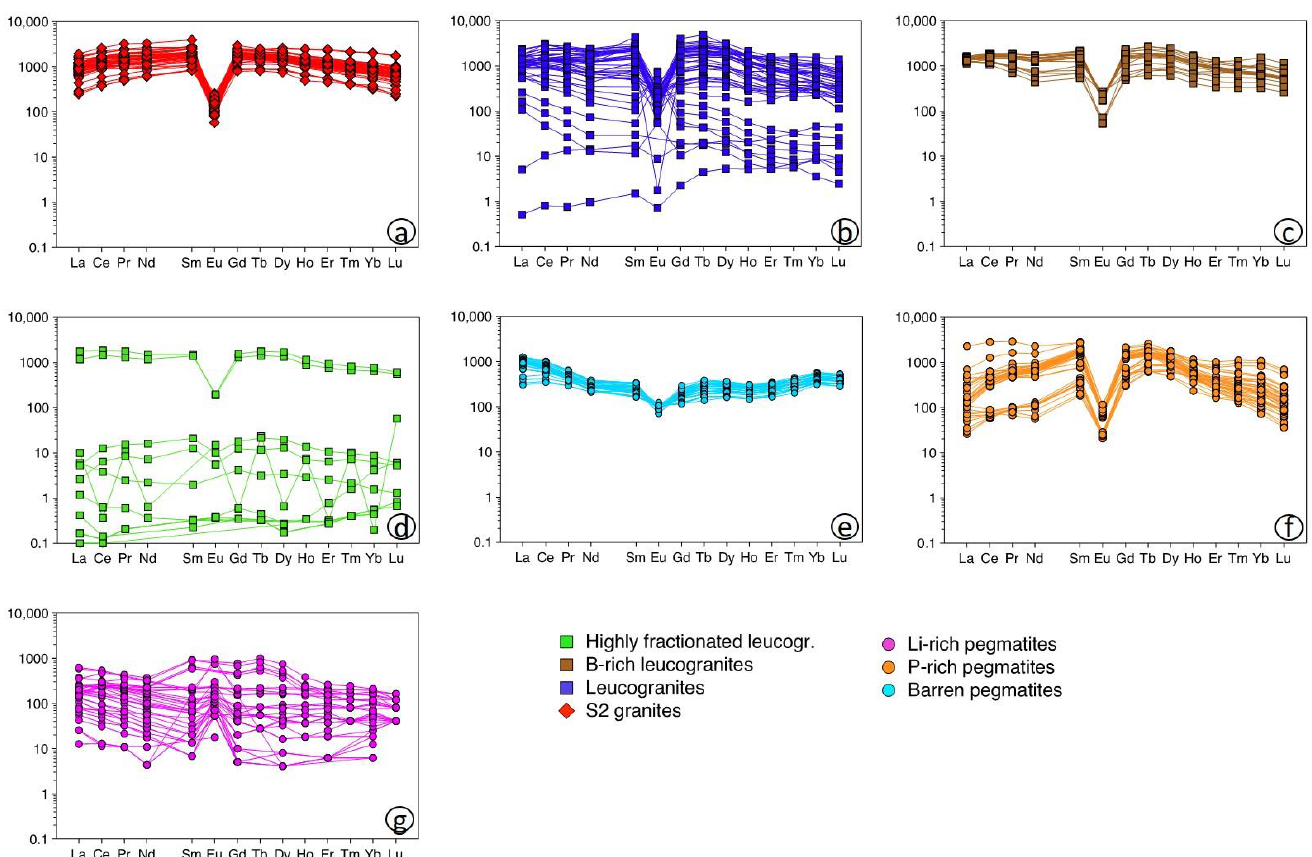
Figure 9. Chondrite-normalized (McDonough and Sun, [106]) apatite REE patterns for: ( a ) S 2 granites, ( b ) leucogranites; ( c ) B-rich leucogranites; ( d ) highly fractionated leucogranites; ( e ) barren pegmatites; ( f ) P-rich pegmatites; and ( g ) Li-rich pegmatites.